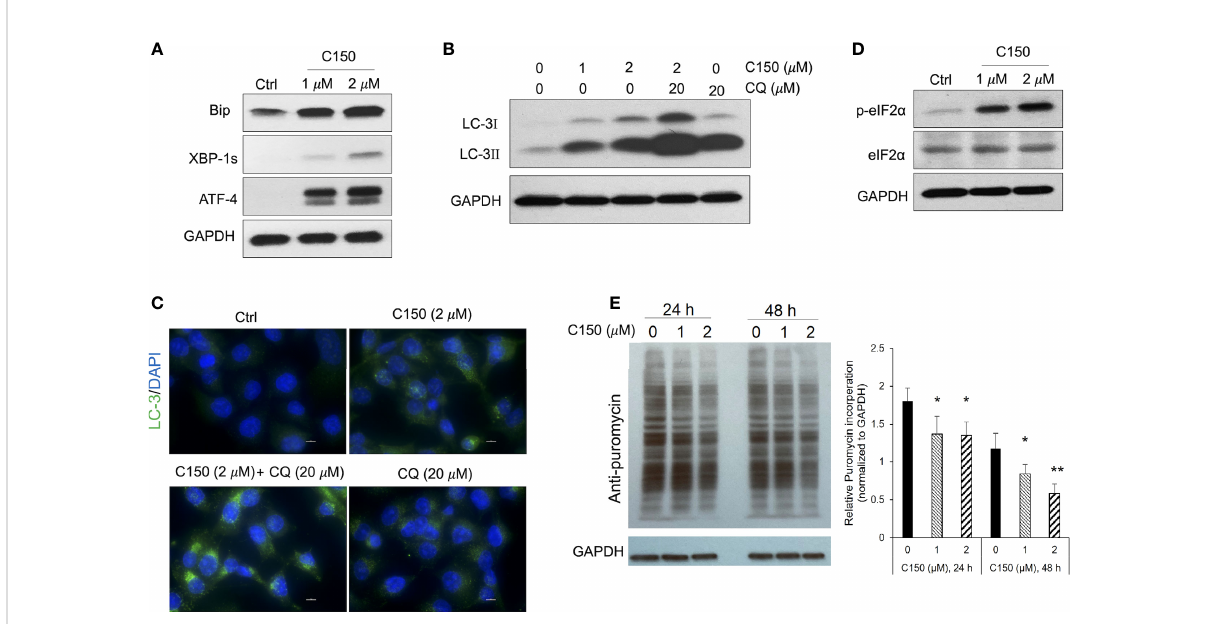
FIGURE 2 C150 induced ER stress, resulted in autophagy and attenuation of protein translation in PANC-1 cells. PANC-1 cells were treated with DMSO (Ctrl) or C150 (1 m M and 2 m M) for 24 h. (A) Western blots of ER stress makers. GAPDH was blotted as loading control. (B) Western blots of the autophagy marker LC-3. CQ, chloroquine (20 m M, 4 h treatment). (C) Immuno fl uorescence staining for LC-3 puncta. Cells were fi xed and stained against LC-3 (green) and DAPI (blue). Scale bar, 10 m m. (D) Western blots of eIF2 a and p-eIF2 a . (E) Puromycin incorporation showing protein synthesis inhibition. PANC-1 cells were treated with 2 m M puromycin for 20 min after 24 or 48 h of treatment with C150. Total cell lysates were analyzed and blotted with anti-puromycin antibody. GAPDH was blotted as loading control. The left panel is a representative image of the Western blots. The right panel shows total band intensity normalized to GAPDH. Data are presented as mean ± SD of three independent experiments. * p < 0.05, ** p < 0.01 (vs. Ctrl) by one-way ANOVA with Tukey HSD